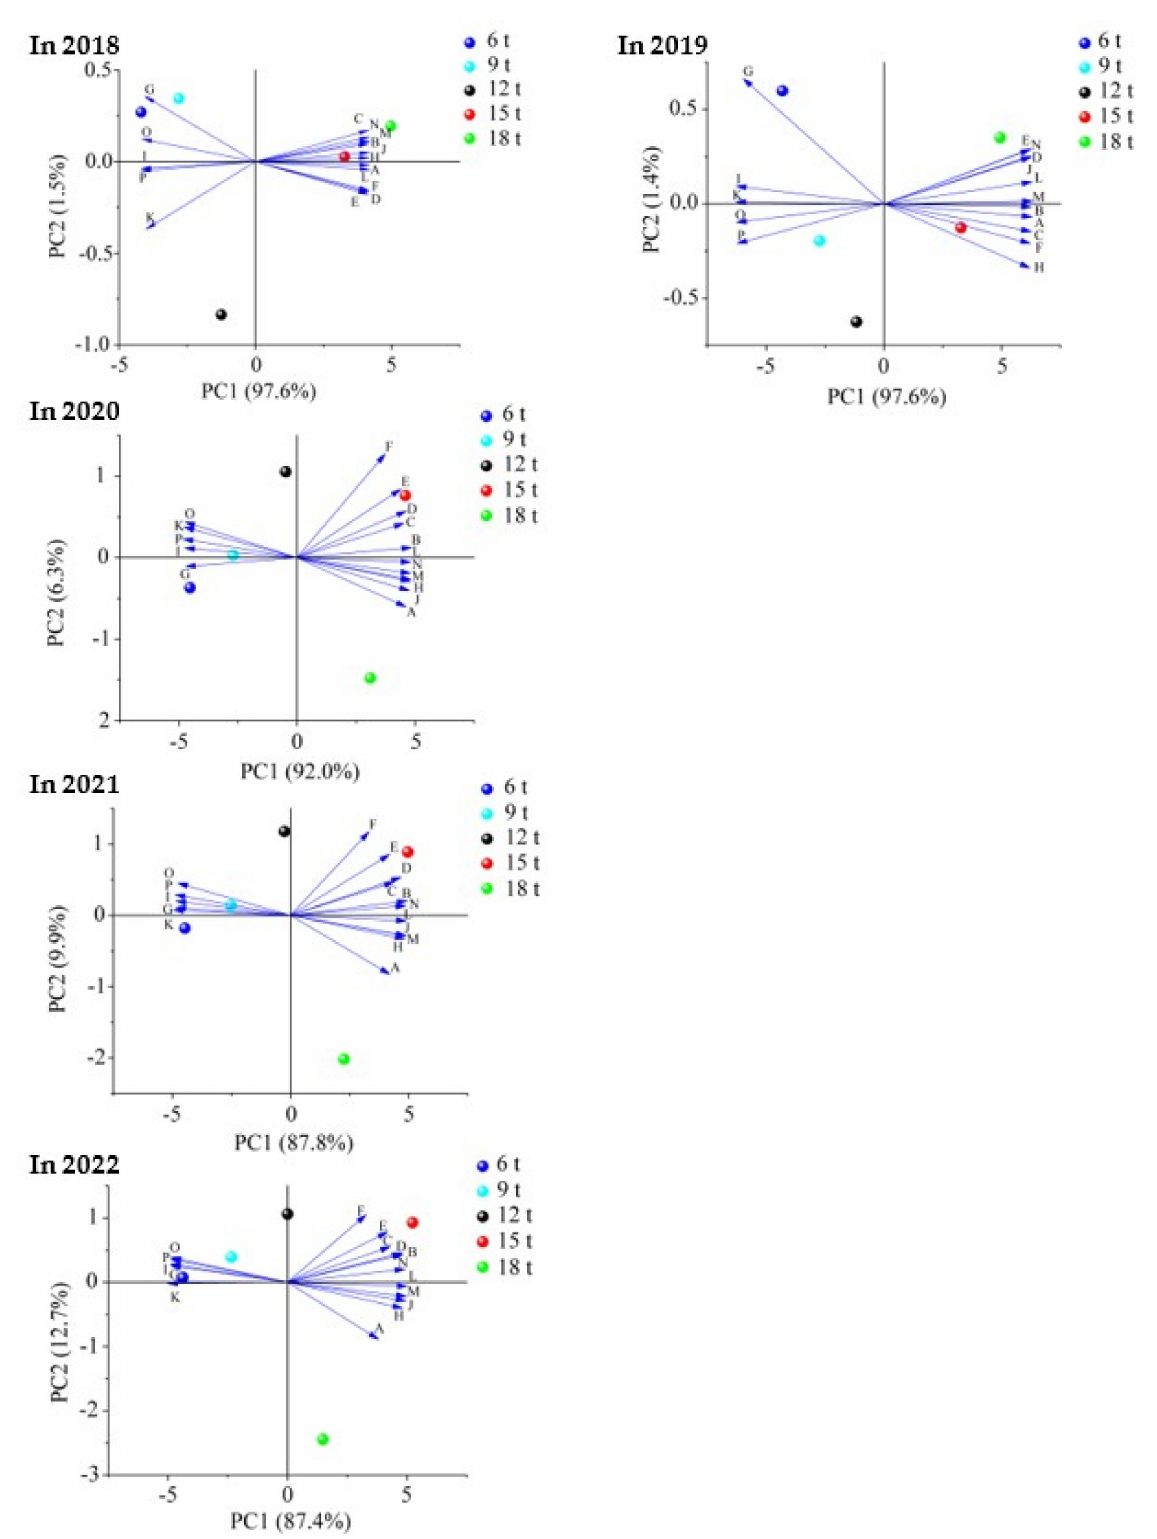
Figure 9. Principal component analysis of soil and tea indexes of different years after the use of sheep manure fertilizer with different dosages. ( A ) pH value; ( B ) tea yield; ( C ) tea polyphenols; ( D ) theanine; ( E ) amino acid; ( F ) caffeine; ( G ) nitrate nitrogen; ( H ) ammonium nitrogen; ( I ) nitrifying bacteria; ( J ) ammonifying bacteria; ( K ) nitrification intensity; ( L ) ammoniation intensity; ( N ) urease; ( M ) protease; ( O ) nitrate reductase; ( P ) nitrite